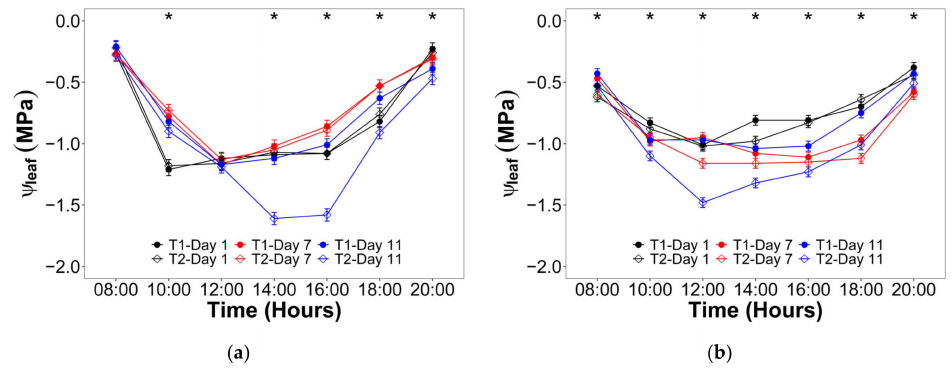
Figure 2. Hourly evolution of leaf water potential ( ψ leaf ) for the irrigation treatments (T1 = Control; T2 = Drought) during the three evaluated days in: ( a ) Vegetative stage; ( b ) Flowering stage. Significant differences between irrigation treatments in the three evaluated days for every hour are indicated by an